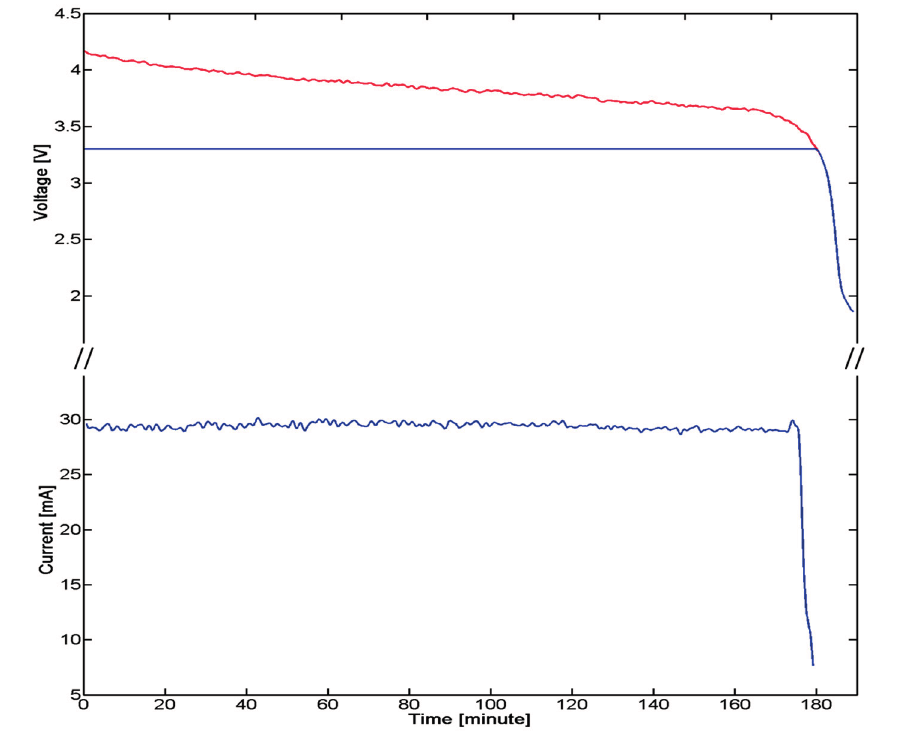
Figure 7. A test of battery life. ( Top ) the trend of the voltage across the battery, over time, is plotted in red, while the actual supply voltage of the circuit, due to the voltage regulator, is plotted in blue; ( Bottom ) the instantaneous current consumed by the system is plotted in blue. The measurement of the pressure is guaranteed, from the device, for at least 170 min in configuration